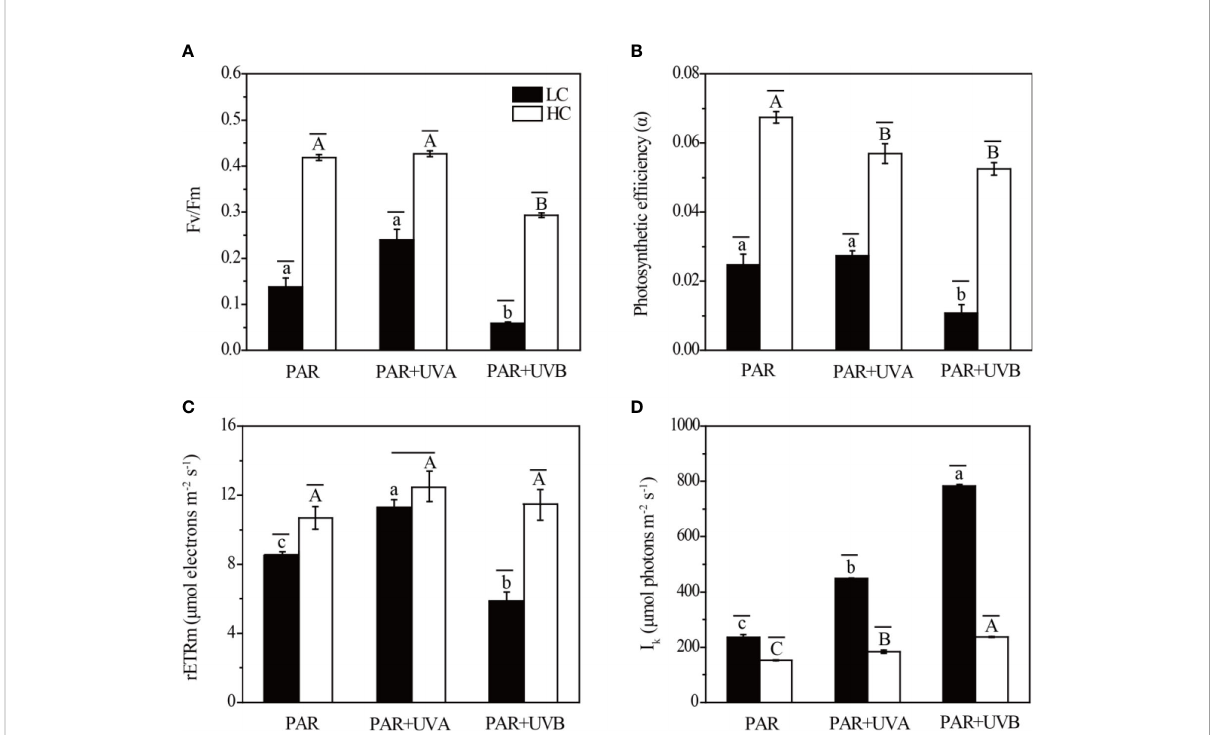
FIGURE 3 The photosynthetic parameters of Rhodosorus sp. SCSIO-45730 under different p CO 2 levels and UVR. (A) the optimal photochemical yield of PSII (Fv/Fm), (B) apparent photosynthetic ef fi ciency ( a ), (C) maximum relative electron transport rate (rETRm), and (D) light saturation point ( I k ). Short horizontal lines represent signi fi cant differences (P<0.05) among CO 2 treatments at the same UVR treatment, while long horizontal lines indicate insigni fi cant differences. Different lowercase letters represent signi fi cant differences (P<0.05) among UVR treatments under LC, and different capital letters indicate signi fi cant differences (P<0.05) among UVR treatments under